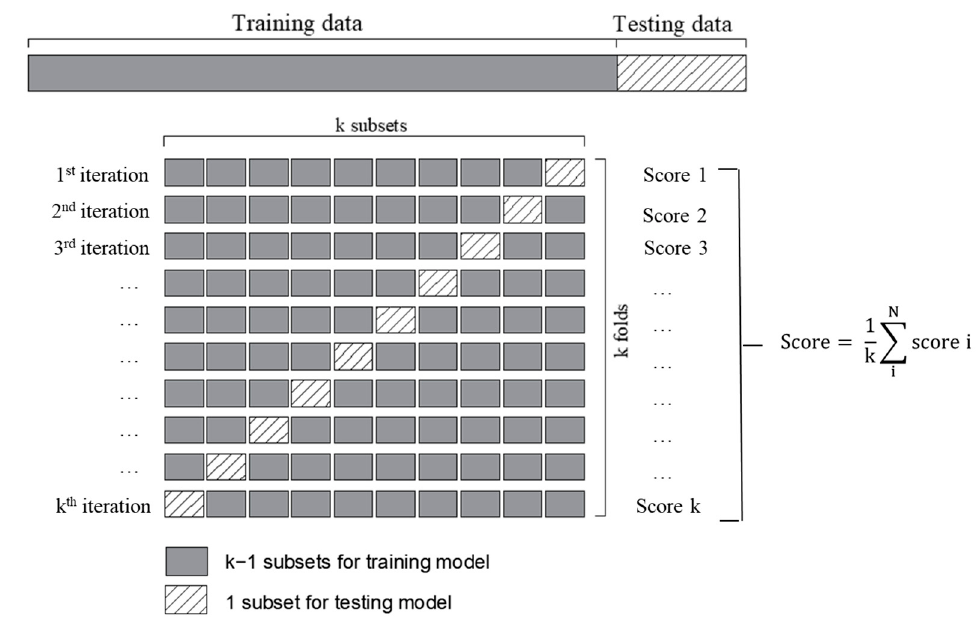
Figure 5. Illustration of the k ‐ fold cross ‐ validation method.